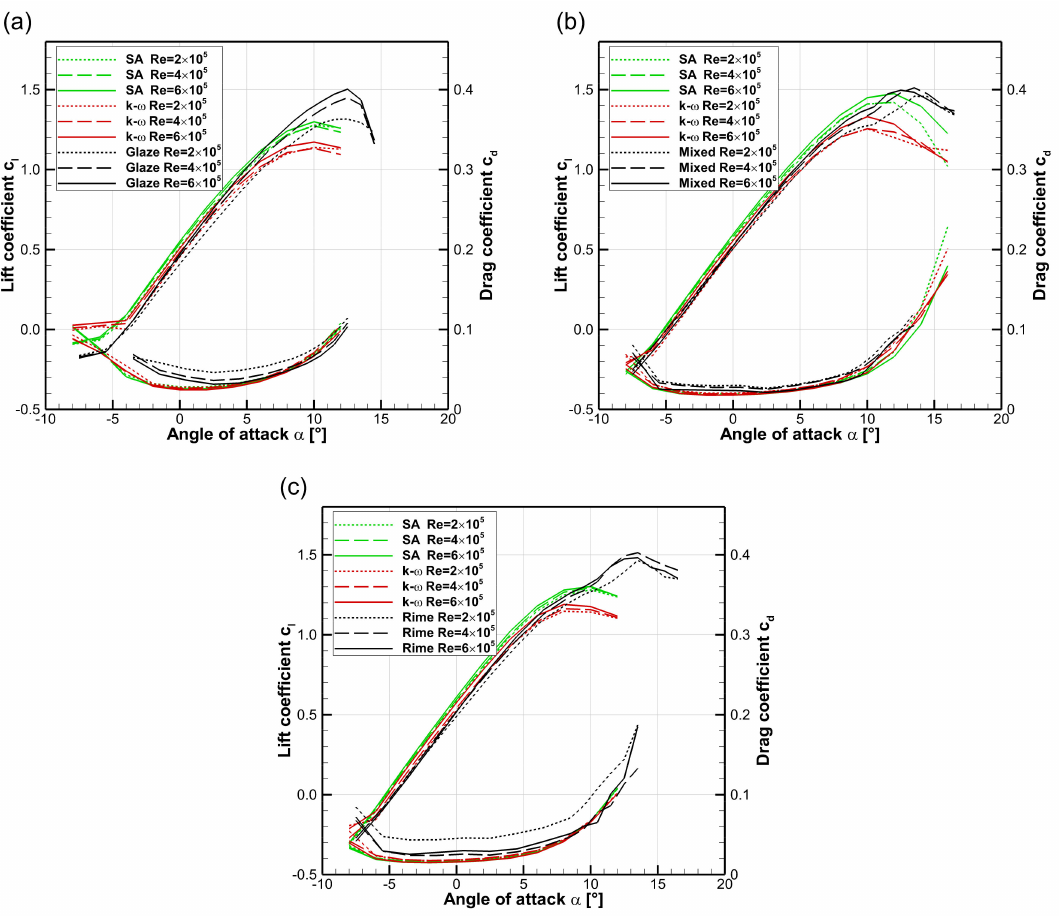
Figure 10. Comparison between numerical and experimental results of lift and drag for the IWT shapes of glaze ( a ), mixed ( b ), and rime ( c